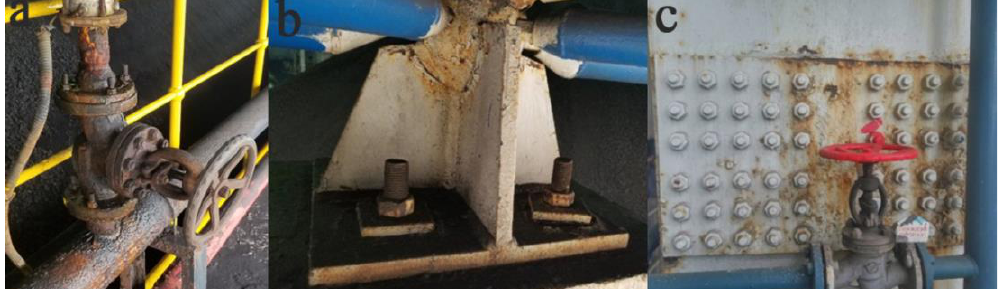
Figure 8. Protective effect of the usual polyurethane oily anticorrosive coating after 6 months: ( a ) pipeline valve, ( b ) dome support of coal yard, ( c ) boiler connecting bolt. ( a ) pipeline valve, ( b ) dome support of coal yard, ( c ) boiler connecting